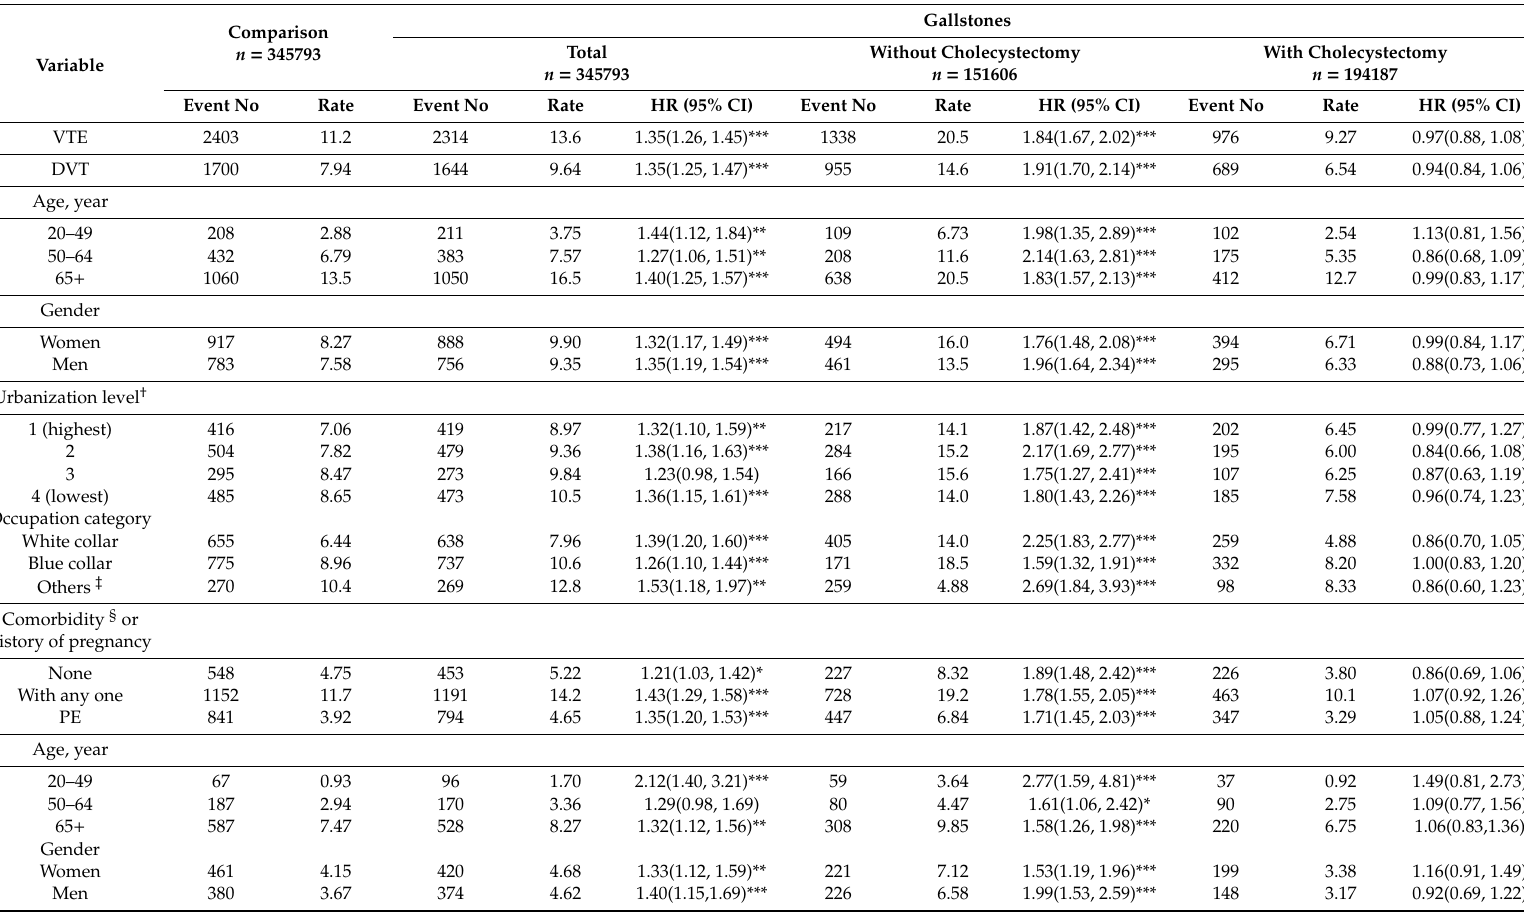
Table 2. Incidence and hazard ratio of venous thromboembolism (VTE), including deep vein thrombosis (DVT) and pulmonary embolism (PE), between patients with and without gallstones based on the stratification of demographic characteristics and the presence or absence of a comorbidity or history of pregnancy.